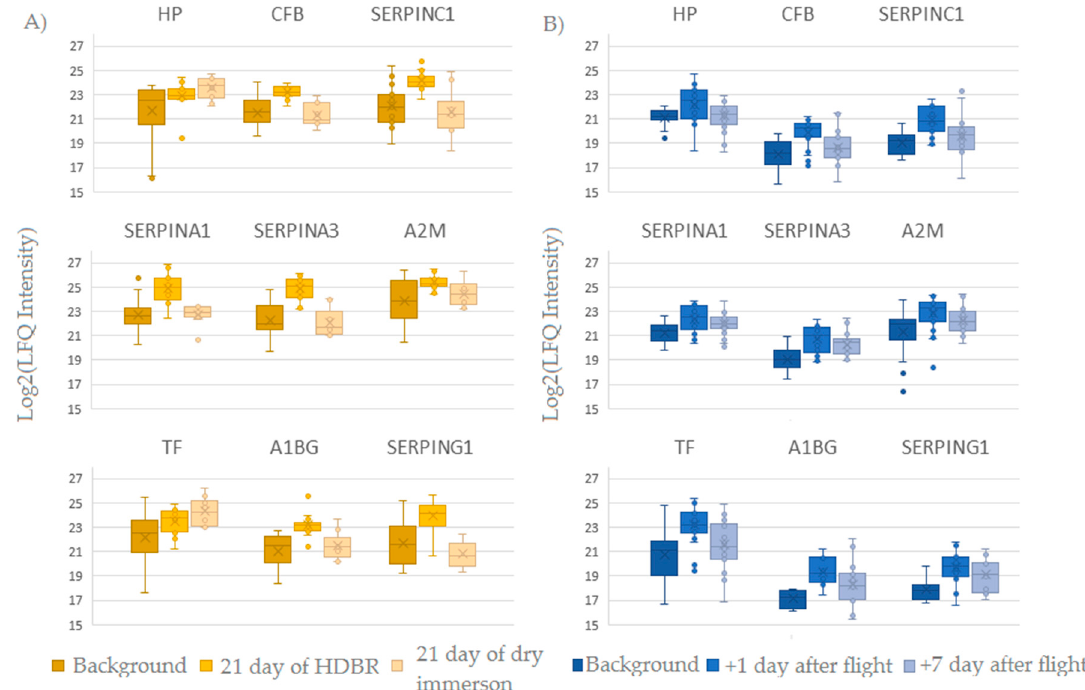
Figure 3. The label-free quantification (LFQ) intensity box plot for nine proteins that change their level at the 21st day in the ground-based experiments ( A ) and after space flight ( B ). The LFQ values are plotted in Log2(x) scale along the vertical axis.